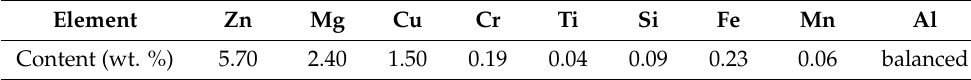
Table 1. Chemical composition of AA